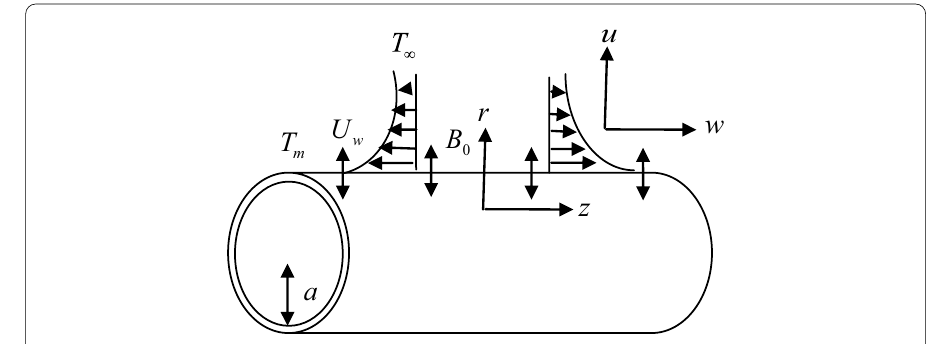
Fig. 1 Flow configuration and coordinate system